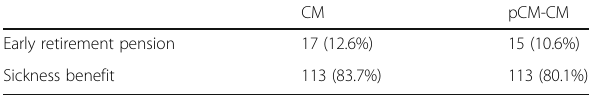
Table 2 (abstract P147). Social parameters